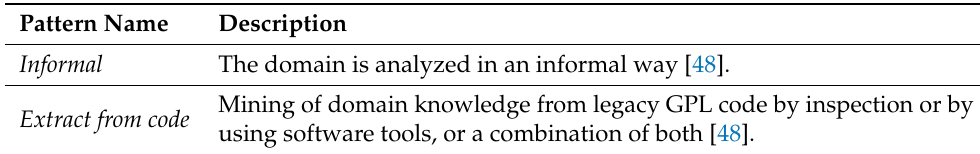
Table 5. Analysis patterns used during the domain analysis phase.